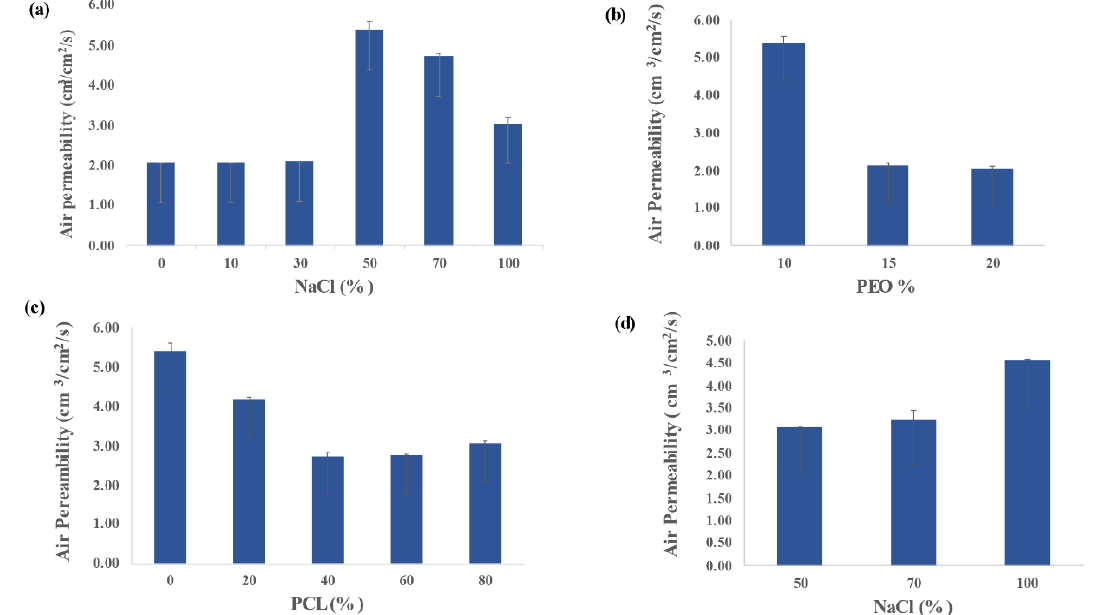
Figure 2. ( a ) The relationship between air permeability and NaCl percentage of porous PLA films. ( b ) The relationship between air permeability and PEO percentage of porous PLA films. ( c ) The relationship between air permeability and PCL percentage of porous PCL/PLA films. ( d ) The relationship between air permeability and NaCl percentage of porous PCL/PLA films.